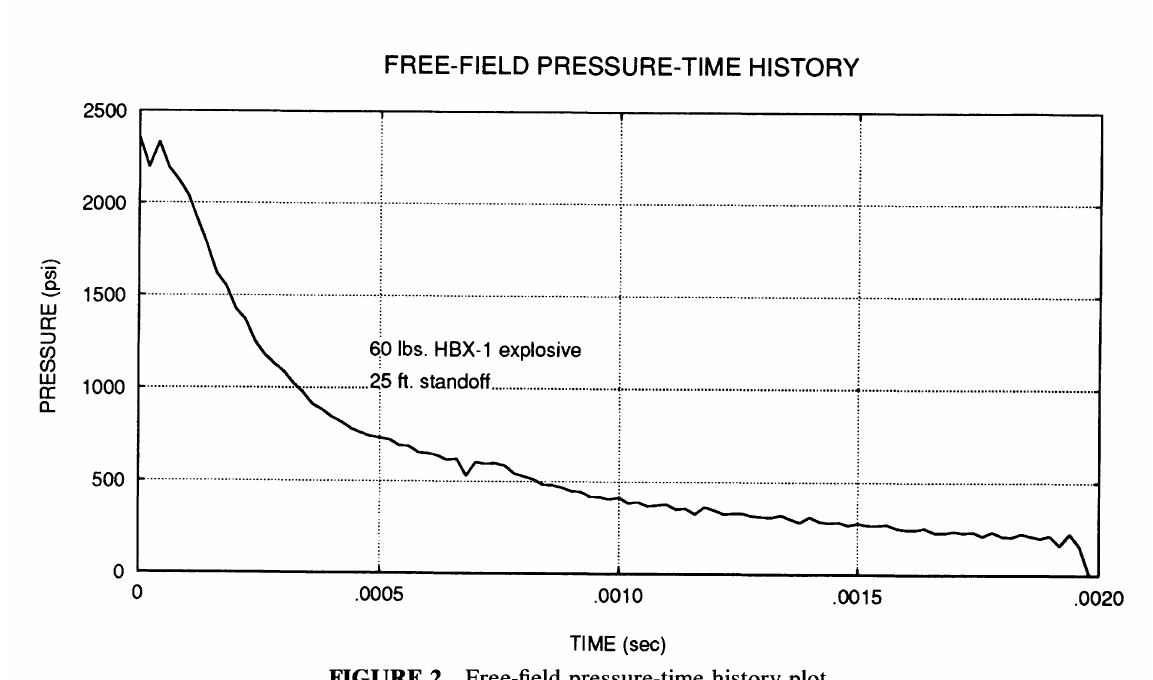
FIGURE 2 Free-field pressure-time history